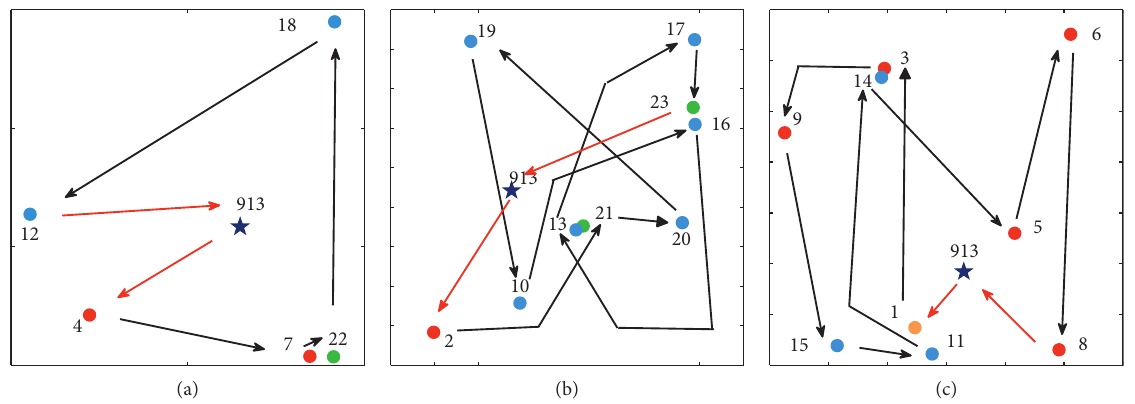
Figure 9: The optimal scheduling route of dispatch center 913. (a) Truck 1 route. (b) Truck 2 route. (c) Truck 3 route.